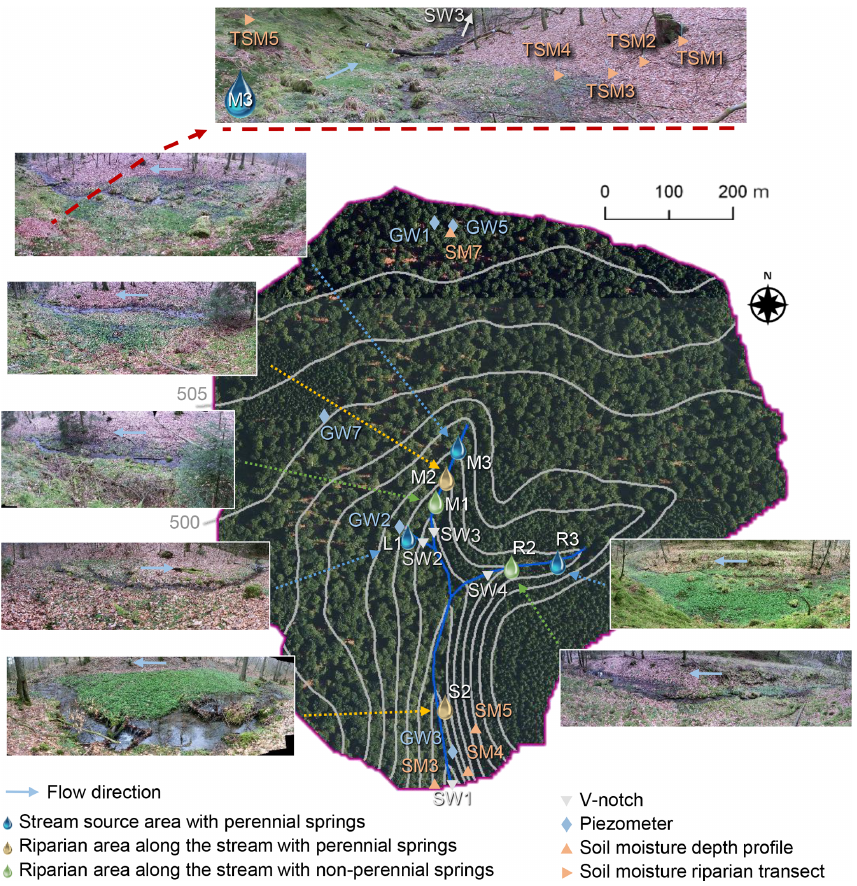
Figure 1. Weierbach catchment with the locations of the installed v-notch weirs for measuring discharge (SW1-SW4), piezometers for measuring groundwater levels (GW1–GW3, GW5, GW7), soil moisture sensors for measuring soil moisture in different depth profiles (SM3-SM5, SM7) and a riparian transect (TSM1-TSM5), and the seven investigated riparian areas along the left (L1), middle (M1–M3), and right (R2, R3) tributary and the central stream (S2). Orthophoto of the catchment: © Administration du Cadastre et de la Topographie 2010 (https://www.geoportail.lu/en, last access: 3 December